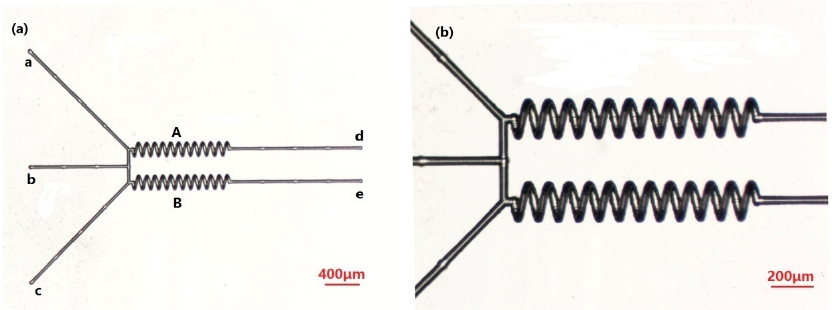
Figure 2. ( a ) Morphology of a multiple channel mixer, observed via optical microscope; and ( b ) detail of mixer with enlarged scale.